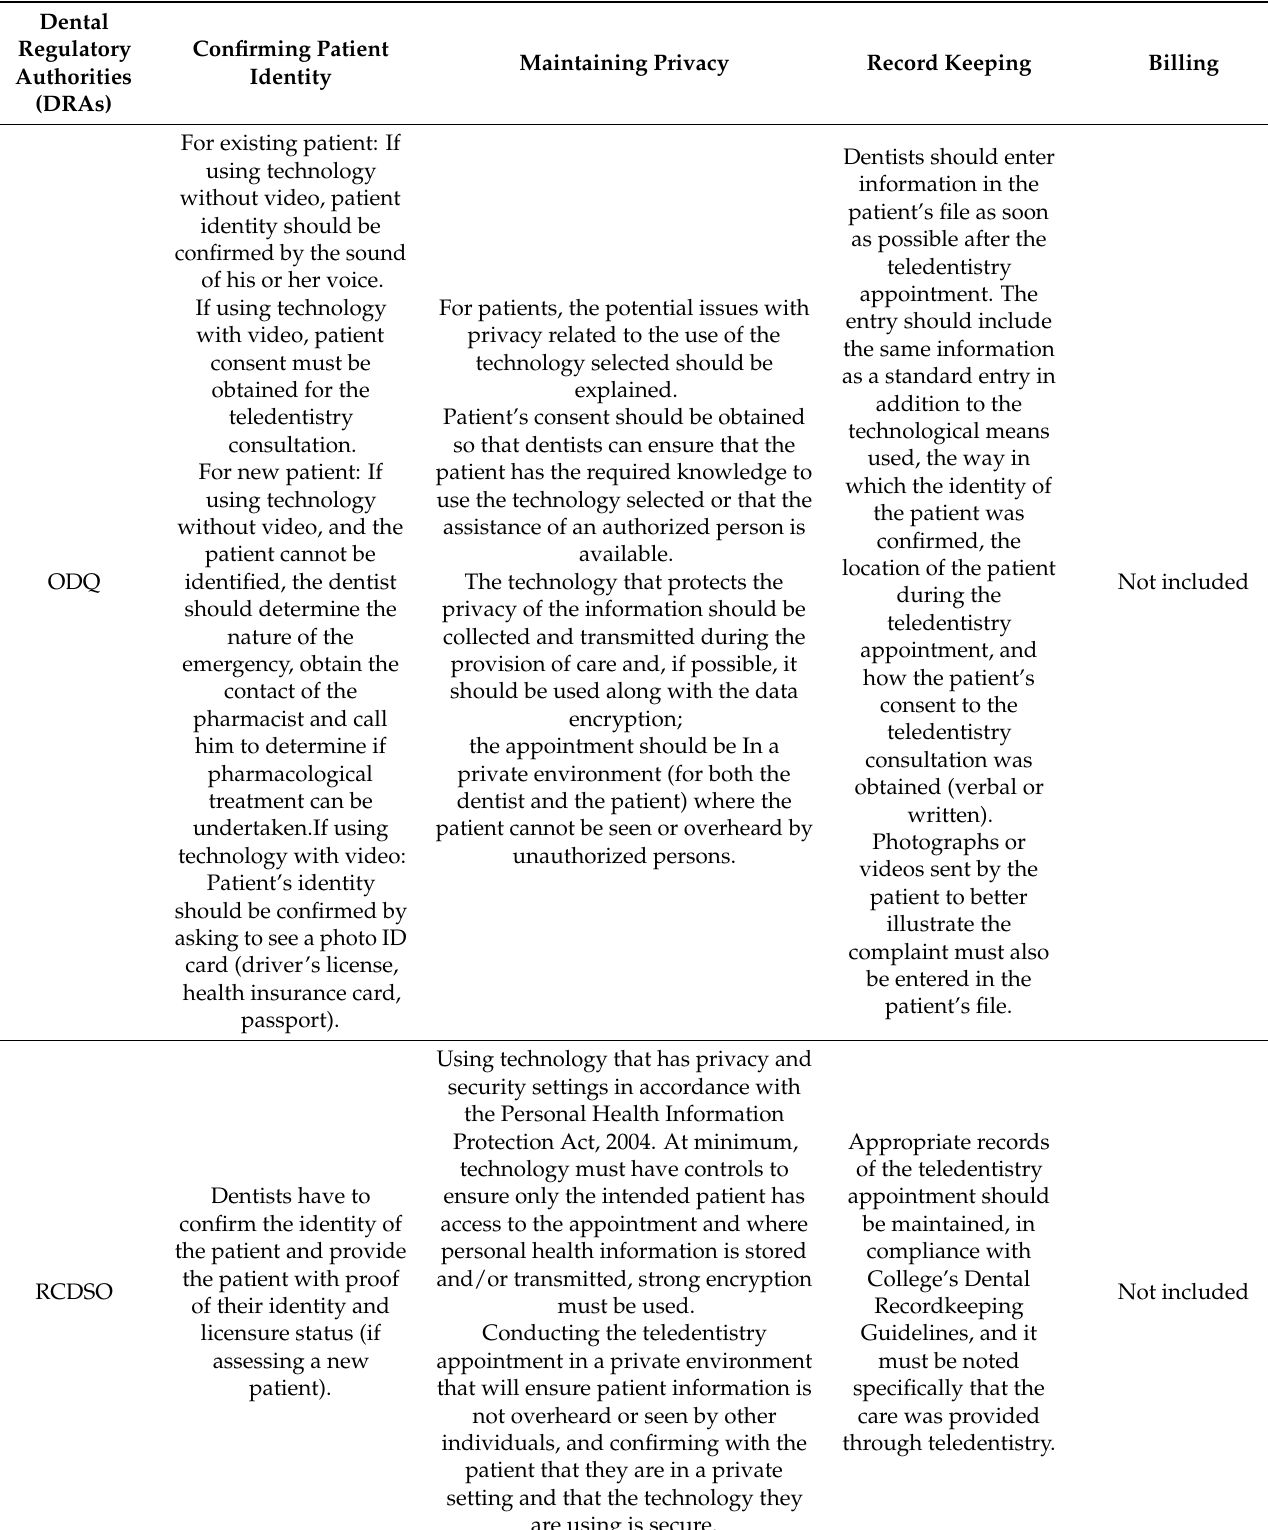
Table 4. Privacy and Billing issues in a teledentistry